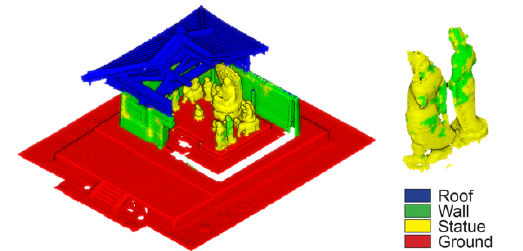
Figure 4. Classification result at level 1 of NCS.